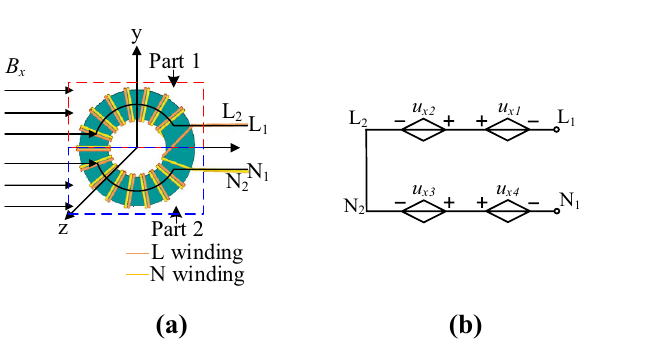
Figure 3. CM choke subjected to the magnetic field in x-direction: ( a ) schematic diagram; ( b ) equivalent circuit